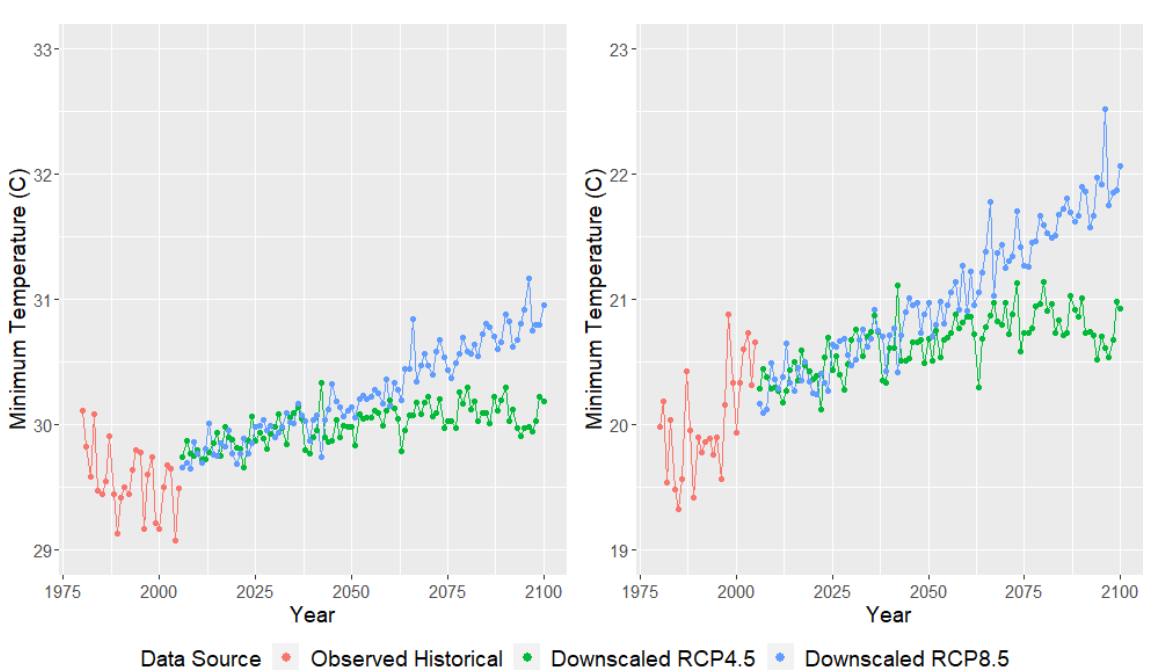
Figure B1. ESM2G mean daily maximum (left panel) and minimum (right panel) temperature ( ◦ C) as a function of year. Observed historical GHCN data from 1980–2005 are plotted in red, while downscaled RCP4.5 and RCP8.5 temperatures from 2006–2100 are plotted in green and blue, respectively. This figure was created using Wickham